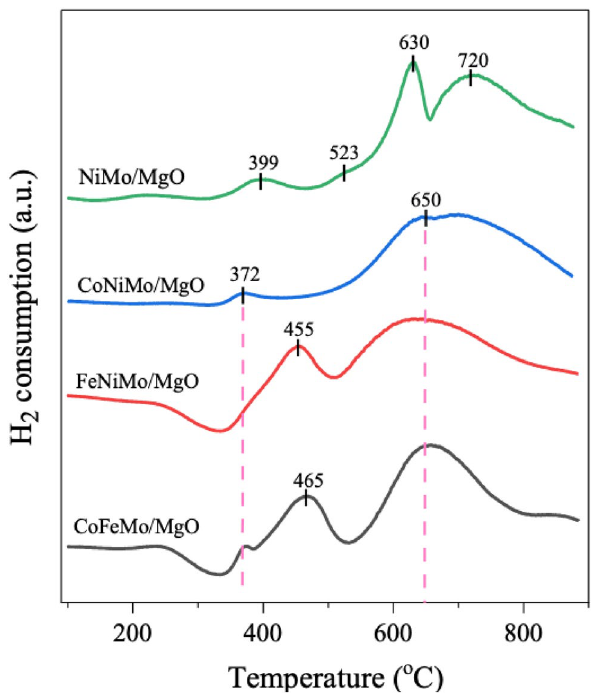
Figure 3. H 2 -TPR profiles of fresh calcined